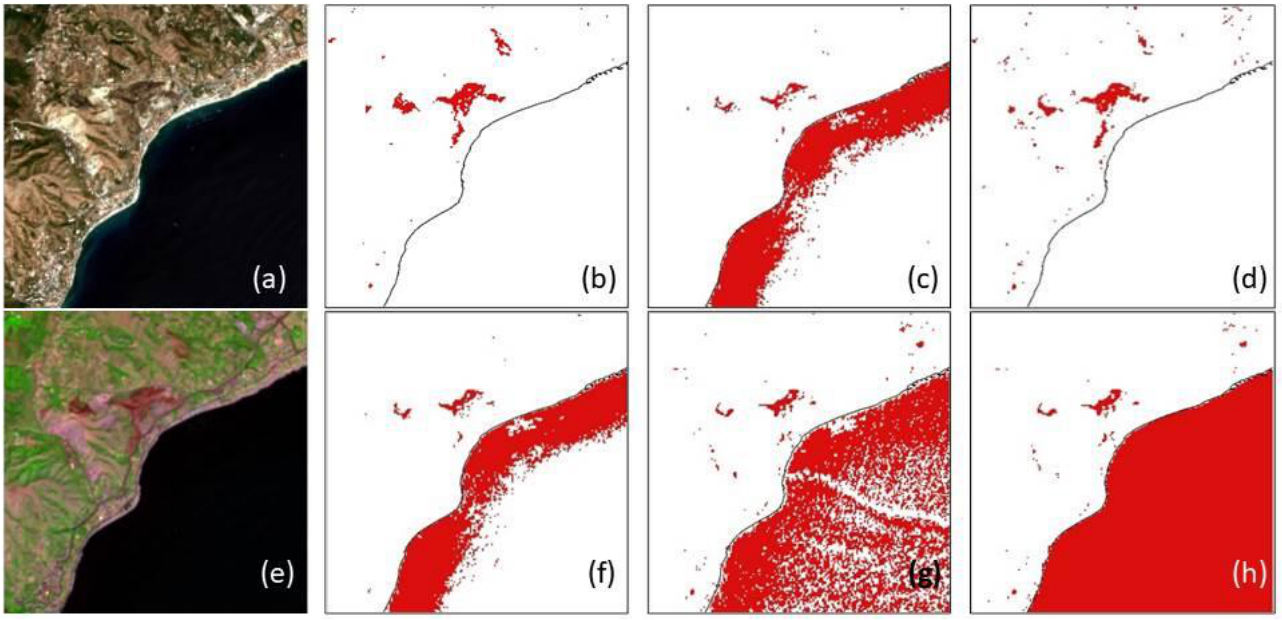
Figure 9. The impact of clouds on BA/NON BA detections supplied by each index: RGB true color composition ( a ), NBR+ ( b ), NDSWIR ( c ), BAIS2 ( d ), false color composition ( e ), NBR ( f ), NBRSWIR ( g ), MIRBI ( h ).